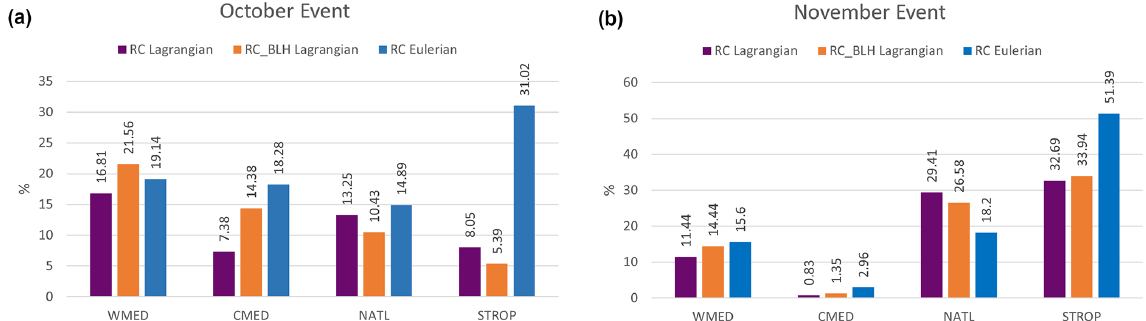
Figure 8. Comparison between the relative contributions provided by the FLEXPART-WRF and the WRF-WVT models for the October event (a) and the November event (b) . WMED, CMED, NATL and STROP correspond to western Mediterranean, central Mediterranean, North Atlantic and tropical/subtropical areas,